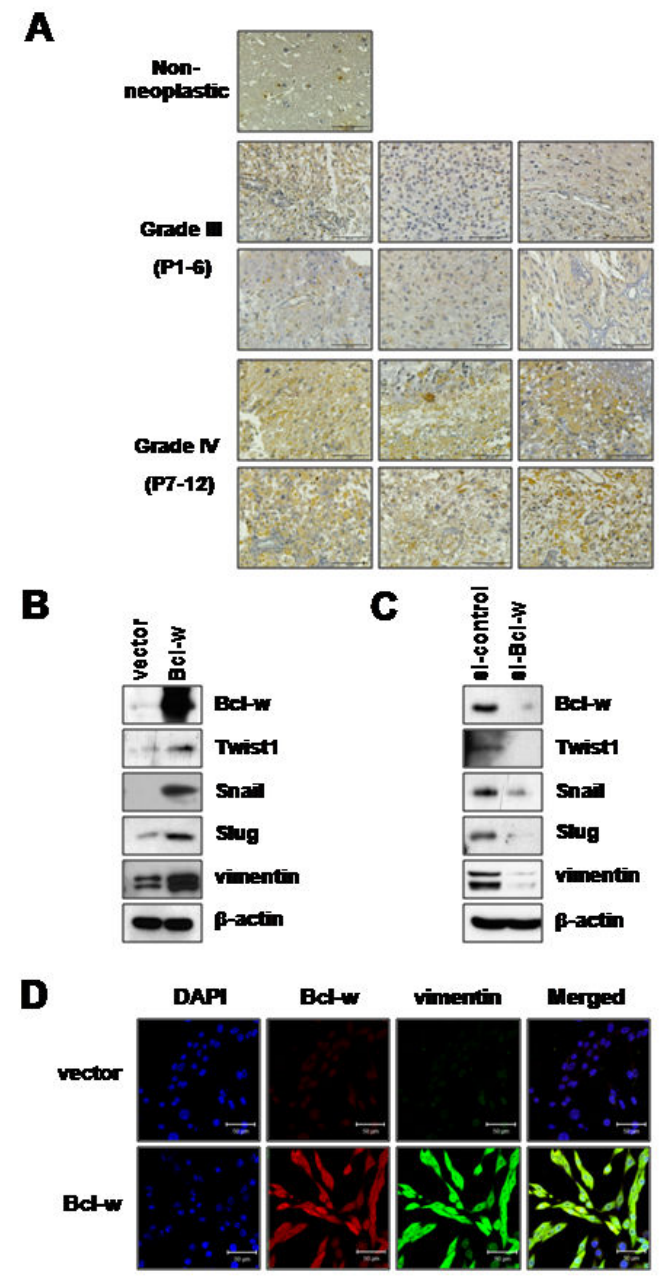
Figure 1. Bcl-w is upregulated in GBM and promotes the expression of mesenchymal-related marker proteins. A , premade brain cancer tissue microarrays (AccuMax, A221-iv) from patients were subjected to immunohistochemical staining with anti-Bcl-w antibody (R & D systems, Minneapolis, MN). Non-neoplastic and corresponding glial tumor grade iii/iv tissues from patients (P1- P12). Bar scale, 100 µm. B , U251 cells were transfected with either empty pcDNA vector or that containing Bcl-w cDNA. Bcl-w expression was detected using Western blotting with β-actin as the loading control. Expression levels of mesenchymal proteins were analyzed using Western blot analysis with anti-Twist1, anti-Snail, anti-Slug, anti-vimentin, anti-E-cadherin and anti-Bcl-w in control vector and Bcl-w-overexpressing cells. C , U251 cells were transfected with control or siRNA oligonucleotides targeting Bcl-w (20nM) for 24 hours. Transfected control or si-Bcl-w U251 cells were subjected to Western blot analysis with the indicated antibodies. D , confocal microscopy analysis of vector or Bcl-w-overexpressing cells showing Bcl-w (Red, Alexa 568) and vimentin (Green, Alexa 488) and DAPI (Blue). Scale bar, 50 µm. doi: 10.1371/journal.pone.0068030.g001 PLOS ONE |